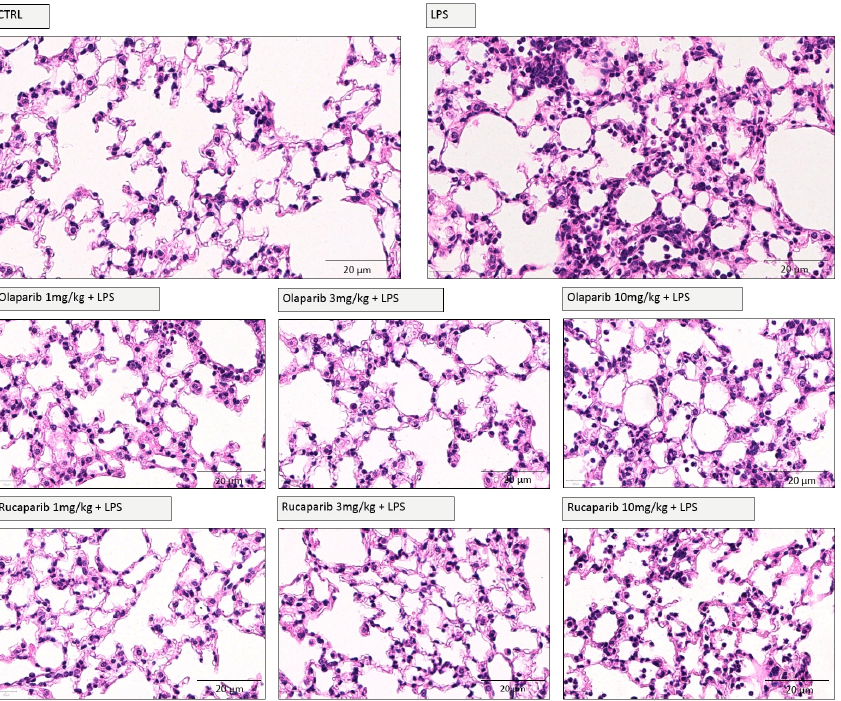
Figure 11. Effect of olaparib and rucaparib on lung histology in a murine model of ALI. C57Bl/6 mice received either PBS (30 µL) or LPS (50 µg in 30 µL PBS) by intratracheal instillation (n = 8 and 12, respectively). After 24 h, lung tissues were analyzed histologically. Representative histological pictures are shown. Please note the increased cell infiltration and inflammation after LPS and the improvement by either of the two PARP inhibitors in the LPS-treated animals.